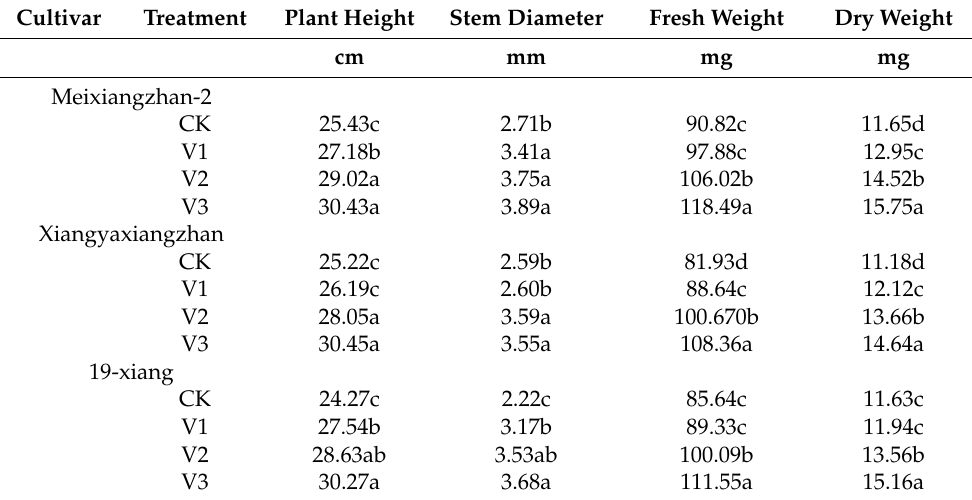
Table 1. Effects of vermicompost incorporation on growth parameters of fragrant rice seedling.